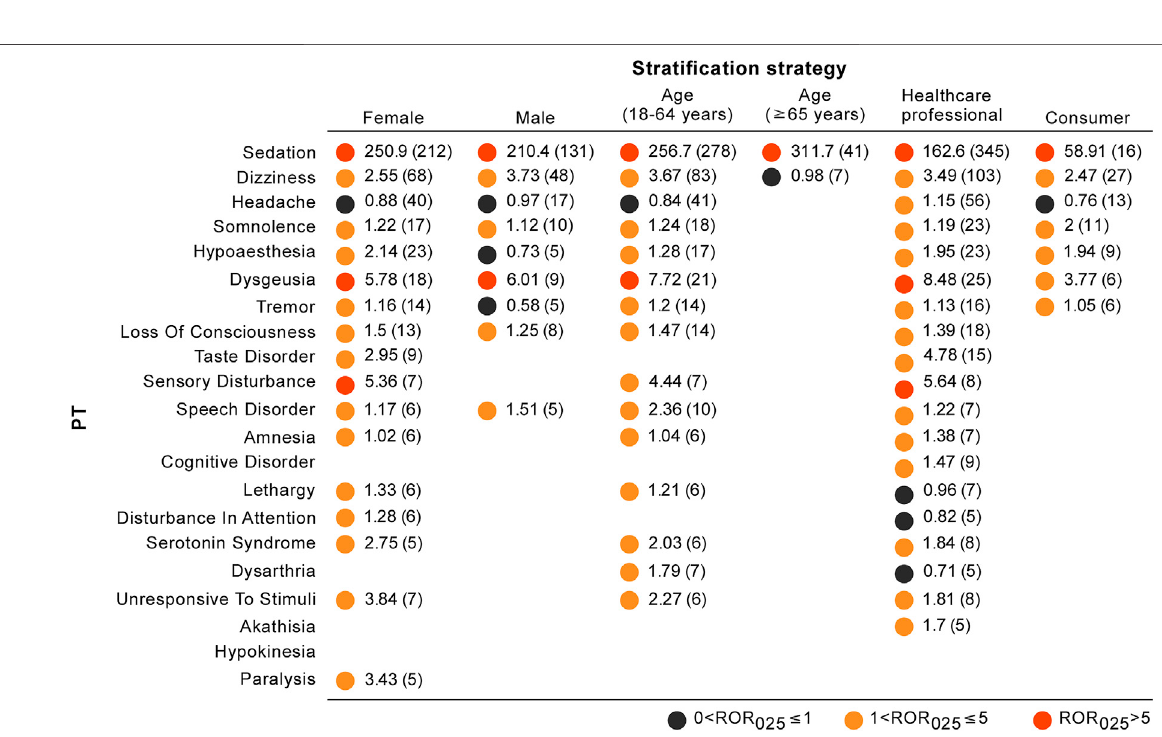
FIGURE 5 | Neurological toxicity spectrums for different strati fi cation strategies. The results are expressed in the form of ROR 025 (n). Blank spaces represent not eligible for disproportionality analysis (AEs with at least 5 reports were eligible for analysis).